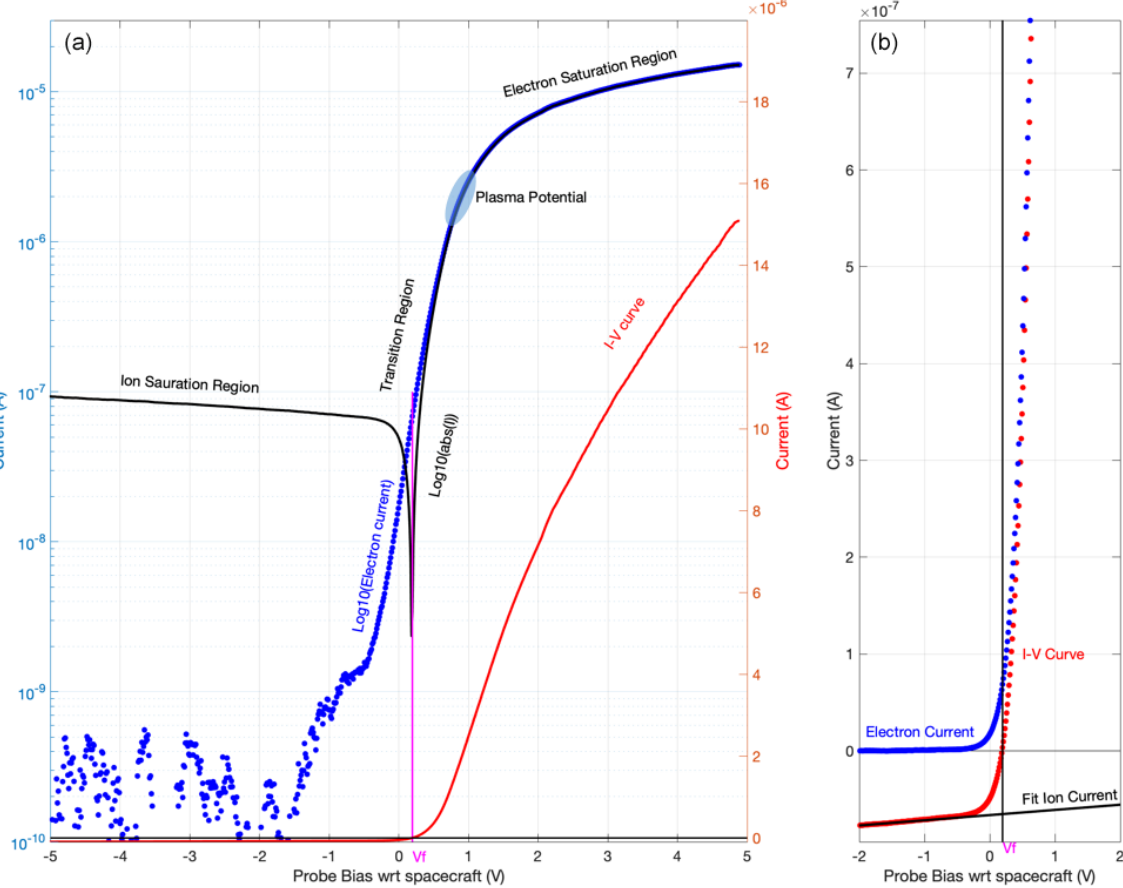
Figure 1. Langmuir probe current-voltage characteristic measured by SLP in the ionosphere on 30 January 2021 at 13:03:47UTC. (a) Full sweep with the measured signal in red (linear scale) and black (semi-log scale). The computed electron current is plotted in blue (semi-log scale). (b) Zoomed-in view of the − 2 to + 2V bias range (linear scale only) with the linear fit to the ion current plotted in black. The computed floating potential Vf is shown in magenta in both